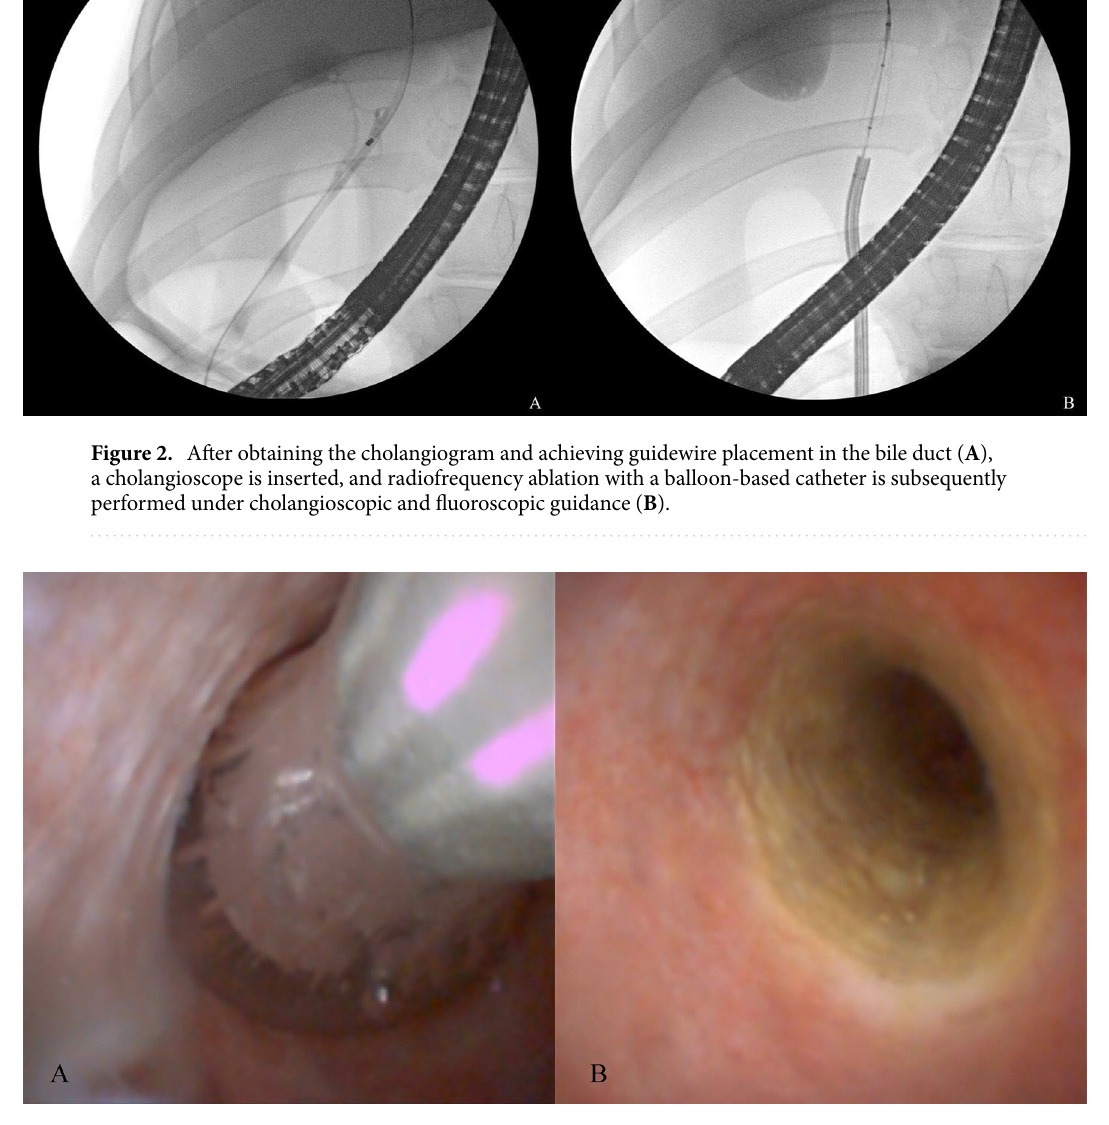
Figure 3. Cholangioscopy can confirm contact between the electrodes and bile duct wall ( A ) and clearly detect the ablation area after the removal of the catheter ( B